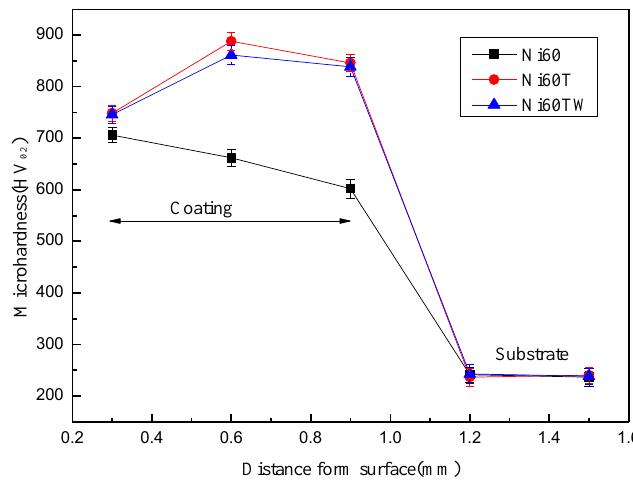
Figure 5. Hardness change of composite ceramic coatings.